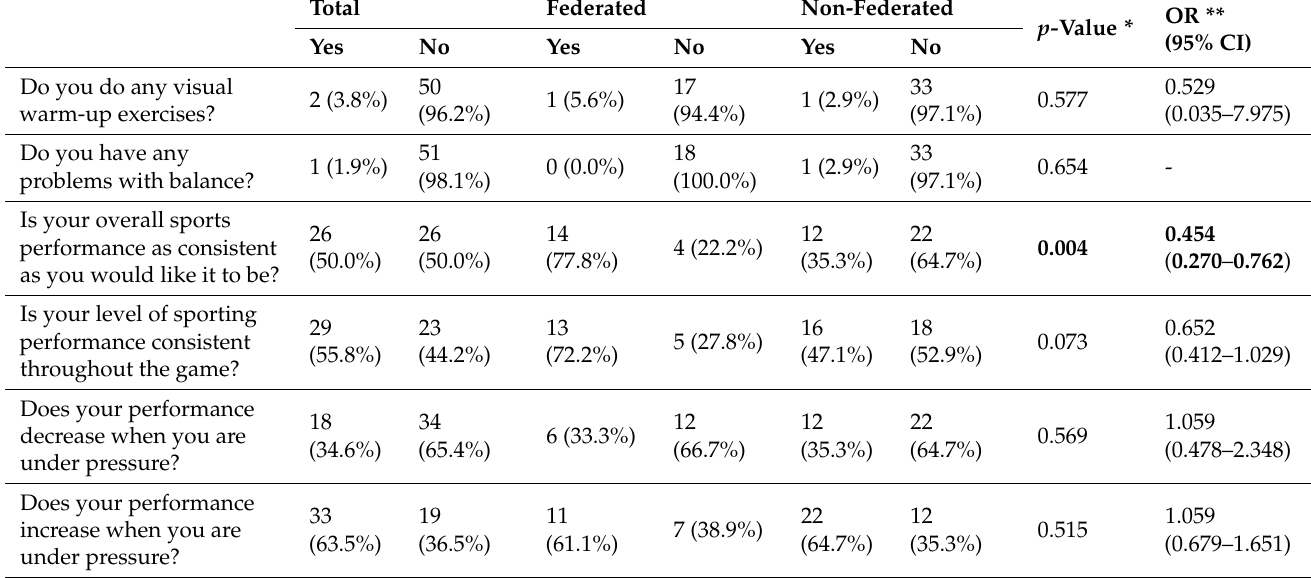
Table 3. Athletes, regarding their sports performance, give the